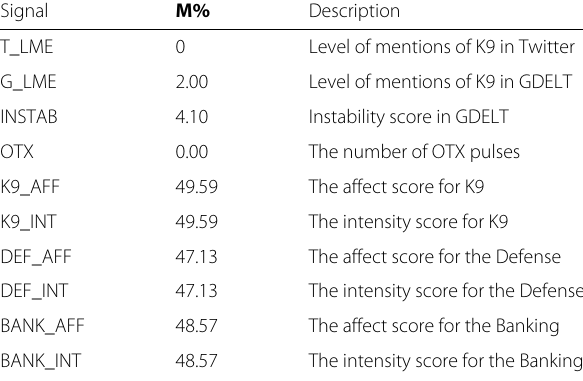
Table 2 A summary of the unconventional signals